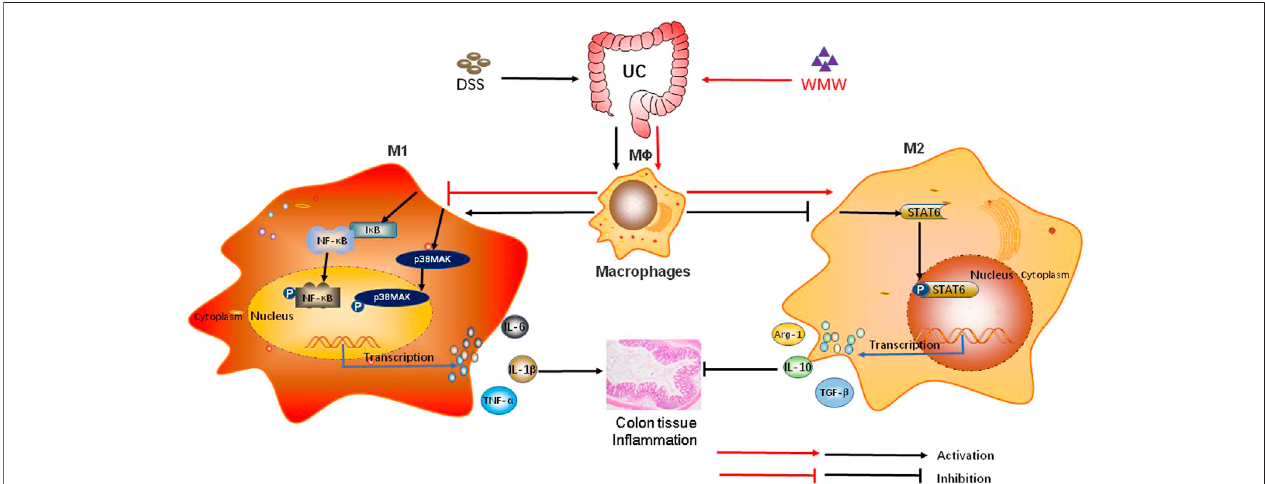
FIGURE 10 | The potential role of WMW in DSS-induced colitis in mice. WMW treatment can Inhibits macrophage activation, Meanwhile regulate colonic macrophages M1/M2 polarization, that is,Inhibits M1 polarization and reduces the pro-in fl ammatory cytokines IL-1 β , IL-6, TNF- α activation and secretion, enhance M2 activity.polarizationandincreasetheanti-in fl ammatorycytokinesIL-10,ARG-1,TGF- β 1activationandsecretion.WMWgraduallyinhibitstheactivationoftheP38MAPK and NF- κ B signaling pathways and further activates the STAT6 signaling